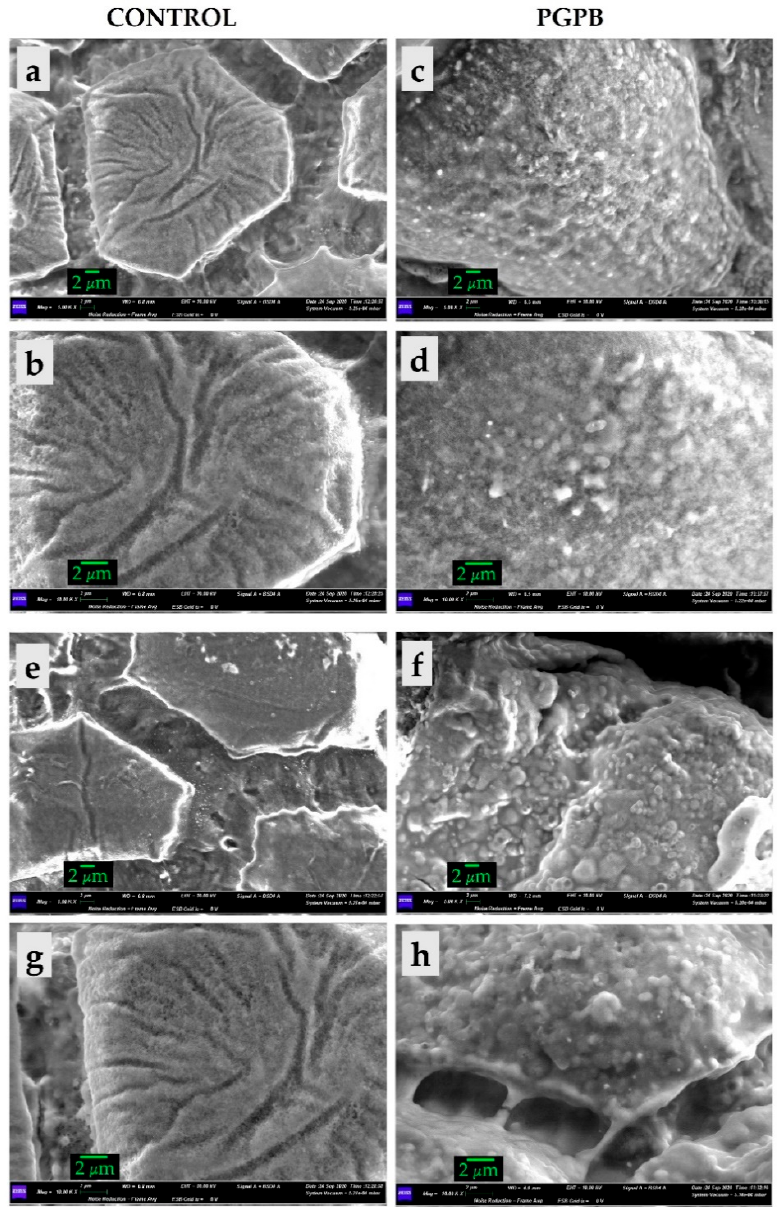
Figure 1. Scanning electron microscope (SEM) micrographs obtained for ( a ) Control (CNT) and inoculated (PGPB) Allium cepa seeds the same day of the inoculation ( a – d ) and after 30 days ( e – g ). Magnitudes: 5000 × ( a, c, e, g ) and 10,000 × ( b, d, f, h ). Scale bars 2 µm. During growth, heights, dry weight, and chlorophylls of the aerial parts were moni- tored. Figure 2 shows the recorded height dynamics for Meranto and Moondance crops from 15 to 150 DAS. The height of the aerial part was significantly affected ( p < 0.05) by the bacterial treatment. Throughout the entire growth period, the PGPB condition rec- orded higher values than the Control, reaching a final average increase of 18% at 150 DAS. Similar trends were also shown by dry weight dynamics (Figure 3); the PGPB condition recorded a final average increase of 23% over the Control. The improvement induced by the bacterial treatment of the seeds was also emphasized by the chlorophyll content. As shown in Figure 4, the treated plants (PGPB) recorded significant increases in chlorophyll content compared to the Control until late maturation (150 DAS), at which an average increase of 43% was recorded.